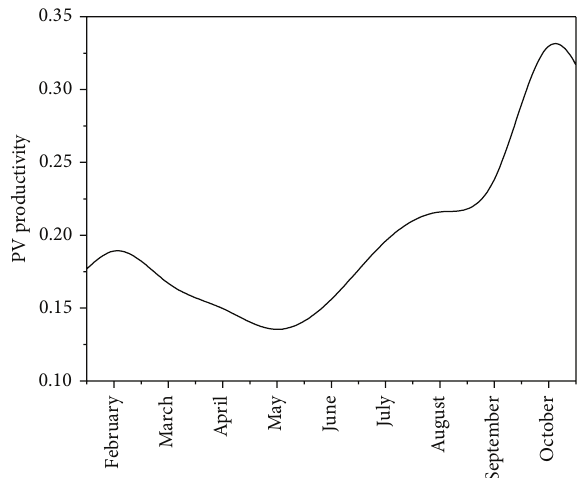
Figure 7: The productivity of solar panels in Arendonk (Belgium, Feb 2012–Oct